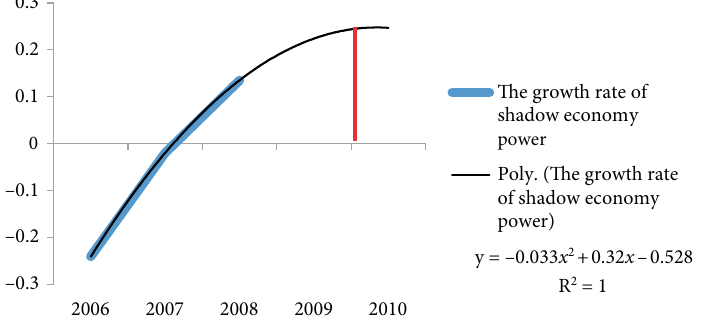
Fig. 4. Dynamics of the shadow economy power growth rate up through 2008 in Lithuania and